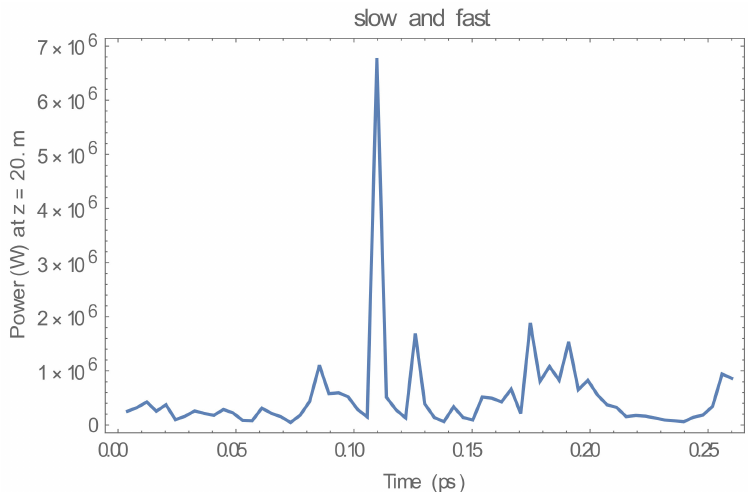
Figure 10. The temporal pulse shape at z = 20.0 m for the sum of the fundamental and the higher- order modes of h = 1, 3, and 5 modes in the two-beam system with the elliptically polarized undulator (color